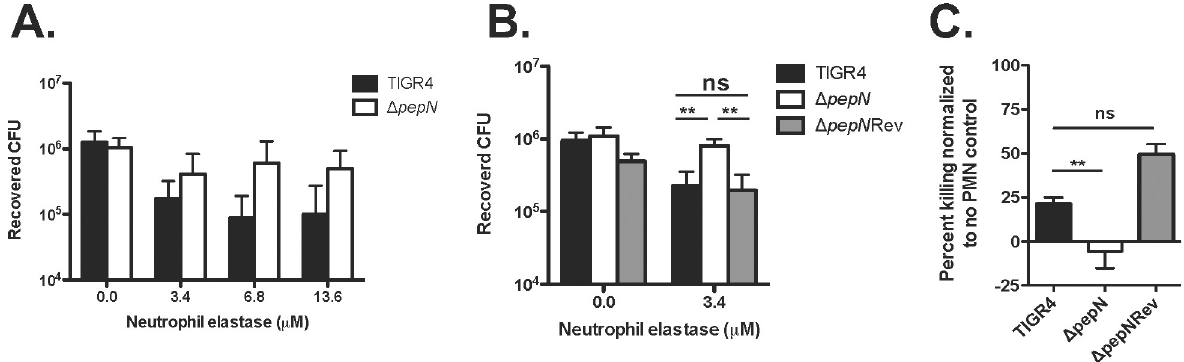
Fig 6. The Δ pepN mutant exhibits enhanced resistance to NE-mediated killing in vitro . and to killing by human neutrophils ex viv o. A) Approximately 5 x 10 5 CFU of the TIGR4 or Δ pepN strain were left untreated or exposed to various concentrations of NE. Samples were diluted and plated to enumerate viable CFU. Data presented are the means ± SD from 3–4 independent experiments. P = 0.004 comparing TIGR4 to Δ pepN across all concentrations of NE; P = 0.0035 evaluating dose dependent effect of NE-mediated killing within each individual strain. Statistical analyses were calculated using two-way ANOVA. B) TIGR4, Δ pepN and Δ pepN Rev cells were left untreated or were exposed to 3.4 μ M NE followed by serial dilution and plating to enumerate viable CFU. Data presented are the means ± SD from 3 independent experiments. �� , P < 0.01; ns = no significant difference. P values were calculated using one-way ANOVA. C) For opsonophagocytic killing experiments, PMNs were isolated from the blood of healthy donors and incubated with pre-opsonized Spn . Viable CFU were determined after serial dilution and plating. The percentage of bacteria killed was determined by comparing surviving CFU for each strain to a no PMN control. Positive percent killing indicates bacterial death while negative percent indicates bacterial growth. Data are shown as the means ± SD from 4 independent experiments with PMNs from four separate donors. P = 0.036 and was calculated using Student’s